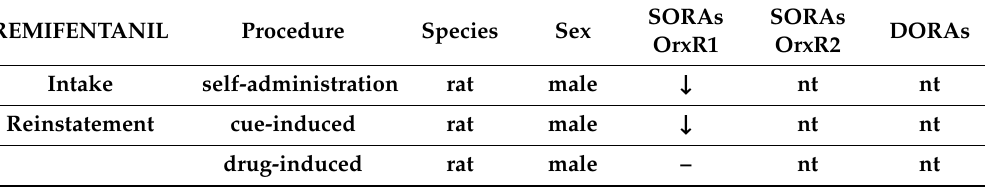
Table 2. Summary of the e ff ect of OrxR blockade on remifentanil-related behaviors.